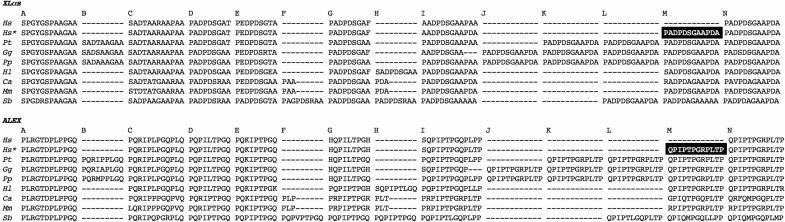
Alignment of Internal Repeat Region in XLαs and ALEX PolypeptidesBlack boxes highlight the position of the disease-linked repeat in the 14-unit human allele (Hs*). Sequences upstream and downstream of the shown region can be aligned unambiguously. Species abbreviations as follows: Hs, Homo sapiens (human); Pt, Pan troglodytes (chimpanzee); Gg, Gorilla gorilla (gorilla); Pp, Pongo pygmaeus (orangutan); Hl, Hylobates lar (gibbon); Ca, Colobus angolensis (colobus monkey); Mm, Macaca mulatta (macaque); Sb, Saimiri boliviensis (squirrel monkey).